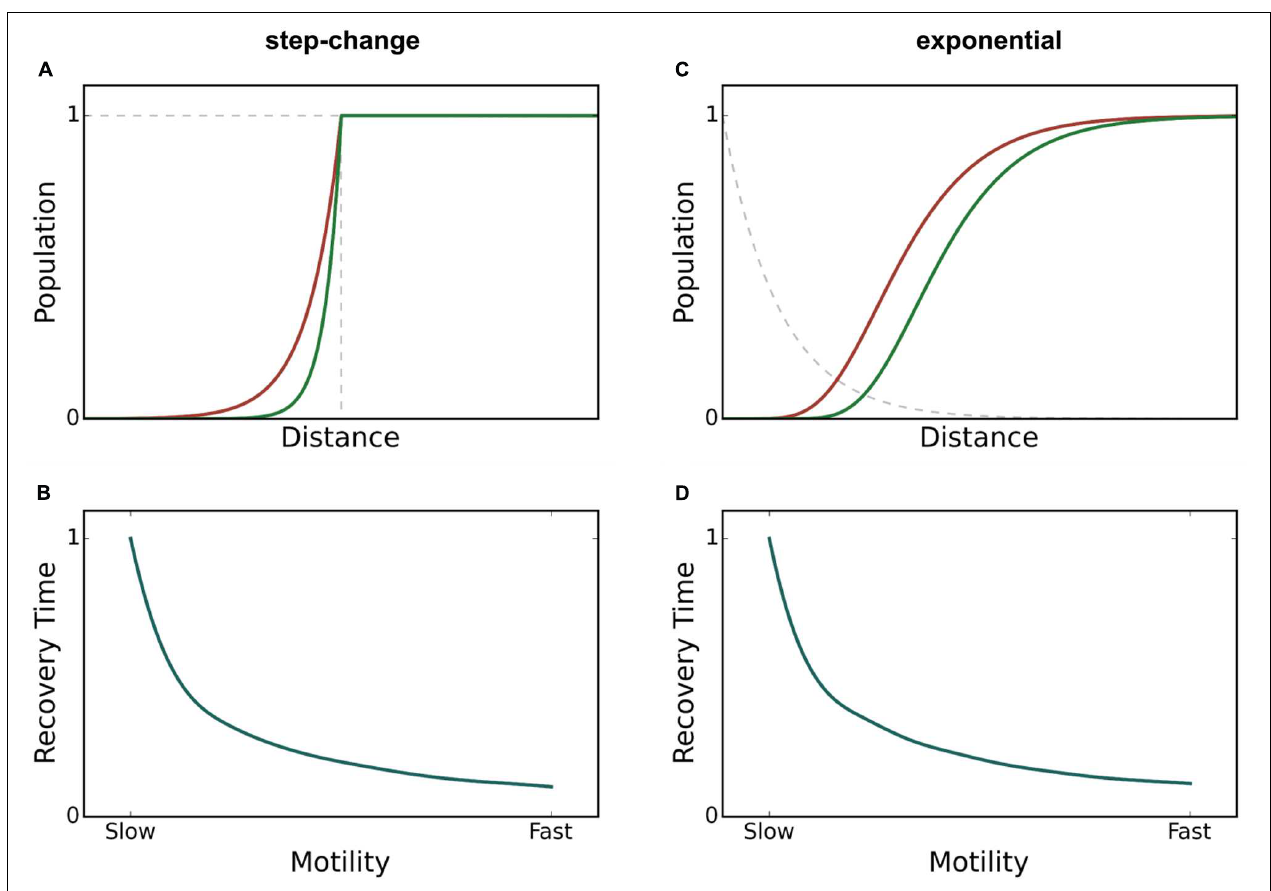
FIGURE 3 | Spatial population density profiles during a perturbation and recovery time – motility relationship for two different perturbation profiles: step-change (A,B) and exponential (C,D). The faster species (green) recovers more quickly after a perturbation than the slow species (red). Regardless of the shape of the perturbation profile, the recovery time decreases as motility increases, verifying that resilience is higher for the faster